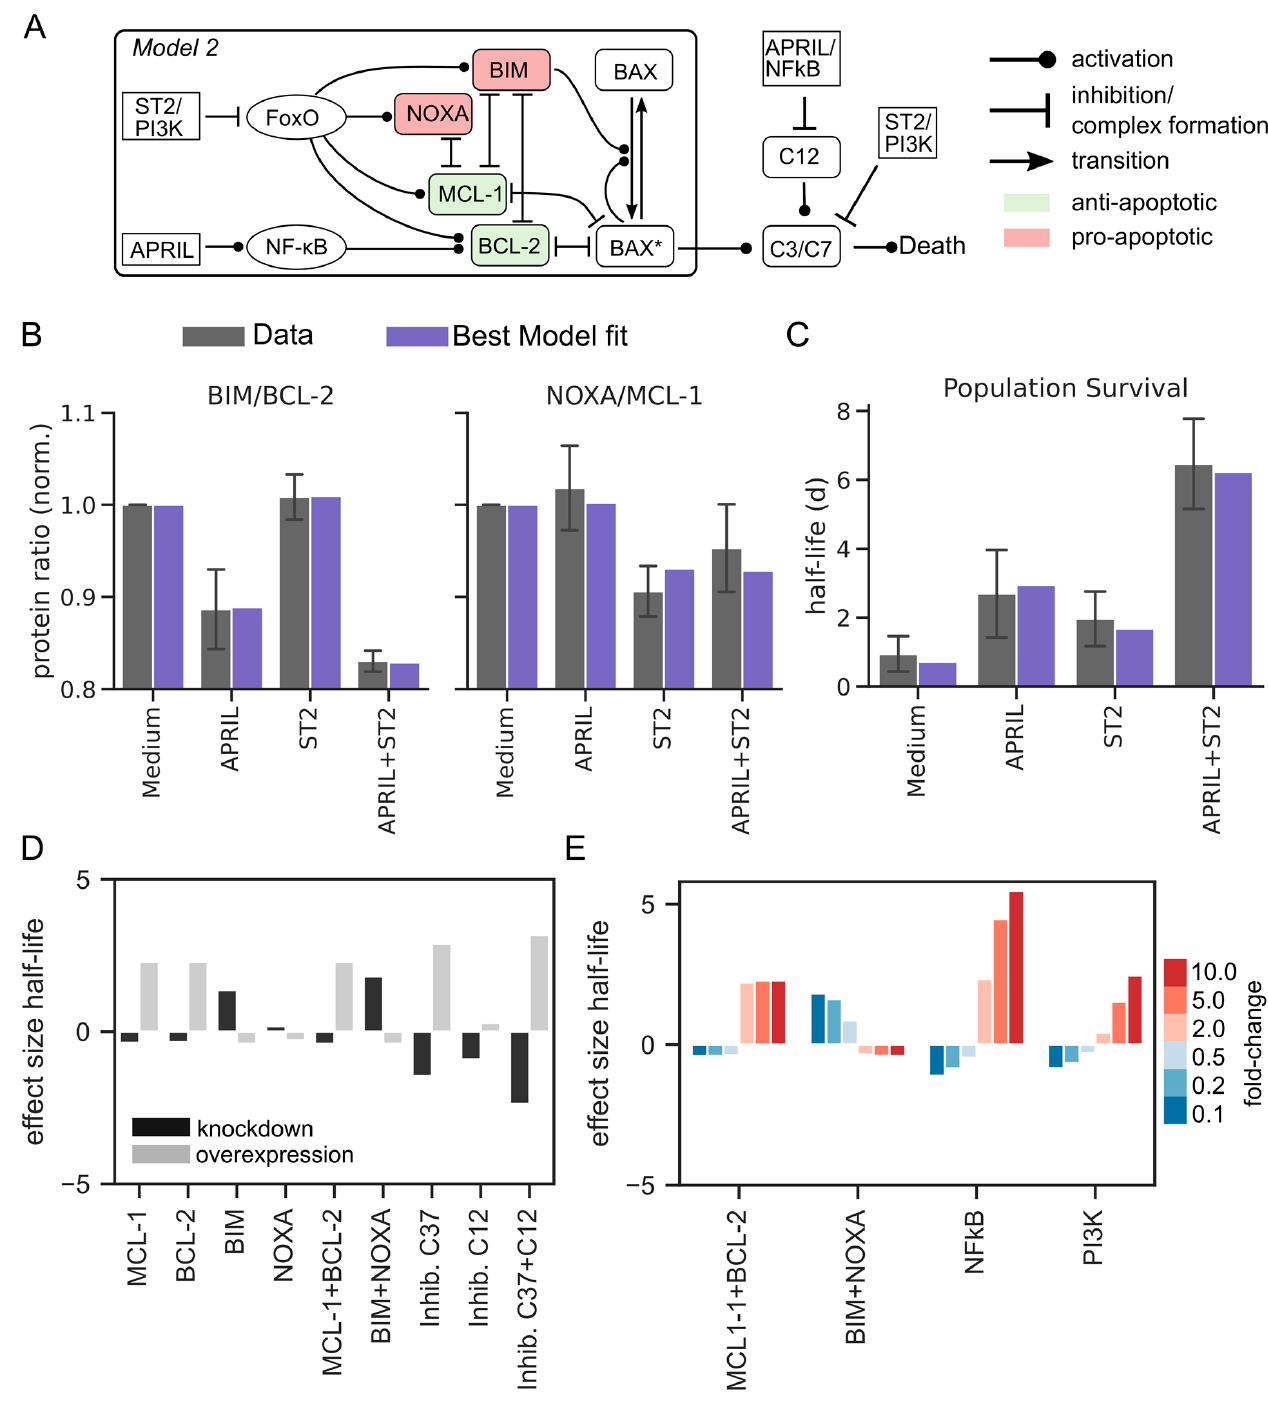
Figure 3. Unifying the data sets on MCL-2 family members and plasma cell survival data requires direct regulation of caspases. ( A ) Model scheme, combination of the mechanistic mitochondrial apoptosis model (see Figure 2B) with ER-stress-induced caspase activation. ( B , C ) Combined model fit to protein data and survival kinetics ( χ 2 = 0.152). Error bars represent standard deviation. ( D ) Effect on half-life for simulated partial inhibition or overexpression of BAX/BCL-2-family proteins and caspases 3, 7, and 12. Parameters were varied by one order of magnitude with respect to the best-fit parameter value. ( E ) Effect of quantitative inhibition or overexpression of NF- κ B, PI3K, and apoptotic regulators on half-life. Parameters were varied as 2-, 5-, or 10-fold change with respect to the best-fit parameter